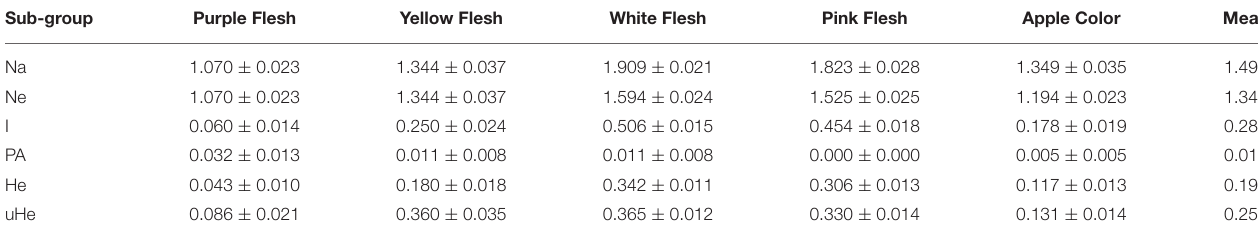
TABLE 4 | Allelic pattern diversity indexes for each subgroup based on the number of different alleles (Na), number of effective alleles (Ne), Shannon’s information index ( I ), private alleles frequency (PA), expected heterozygosity (He), and unbiased expected heterozygosity (uHe). Sub-group Purple Flesh Yellow Flesh White Flesh Pink Flesh Apple Color Mean